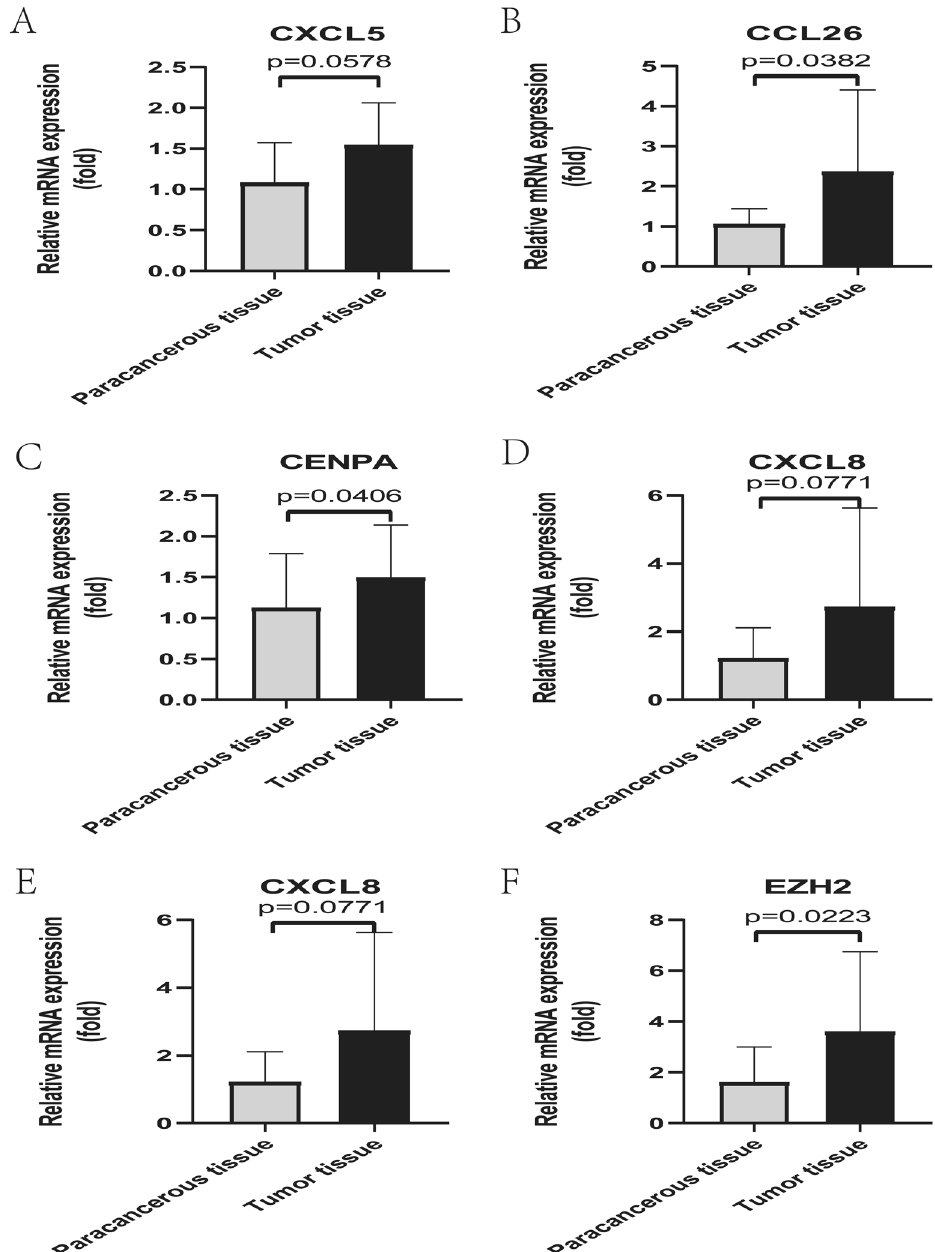
overexpressed in HCC tissues, including CXCL5 ( A ), CXCL26 ( B ). ( C – F ) The qRT-PCR results confirmed that four cellular senescence-associated genes used to construct the prognostic model were overexpressed in HCC tissues, including CENPA ( C ), CXCL8 ( D ), EZH2 ( E ), and G6PD ( F